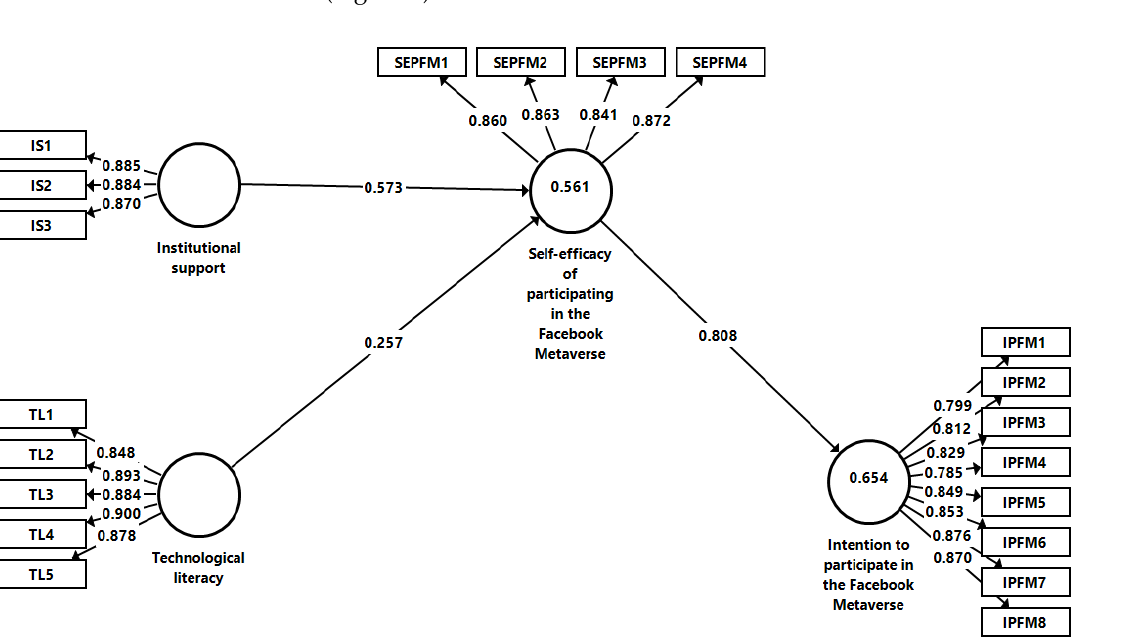
Table 5. Specific indirect effects.